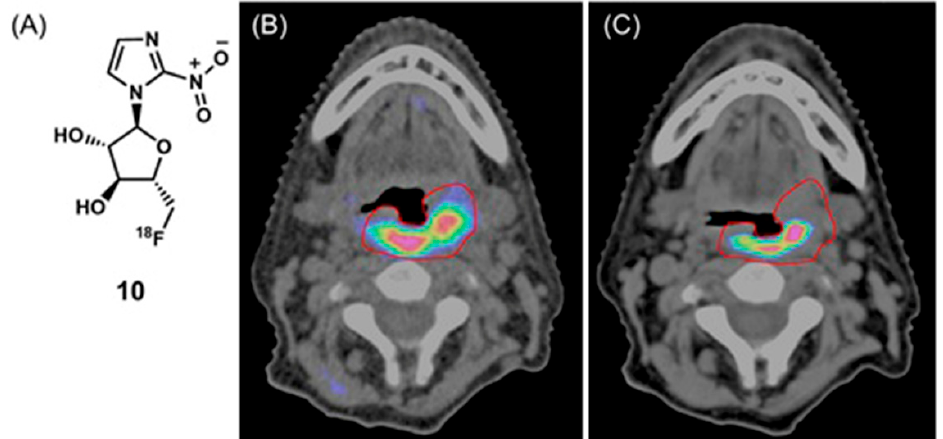
Figure 15. ( A ) Chemical structure of 10 . ( B ) PET–X-ray CT scan of a patient with oropharyngeal cancer before radiation therapy. The red solid line indicates the gross tumor volume. ( C ) Hypoxic volume after 12 Gy radiation therapy. After radiation therapy, the hypoxic volume decreased from 30.9 to 13.7 cm 3 . Adapted from Radiotherapy and Oncology , 105 , 1, Mortensen, L. S.; Johansen, J.; Kalle- hauge, J.; Primdahl, H.; Busk, M.; Lassen, P.; Alsner, J.; Sørensen, B. S.; Toustrup, K.; Jakobsen, S.; Petersen, J.; Petersen, H.; Theil, J.; Nordsmark, M.; Overgaaerd, J. FAZA PET/CT hypoxia imaging in patients with squamous cell carcinoma of the head and neck treated with radiotherapy: results from the DAHANCA 24 trial. 14–20, Copyright 2012, with permission from Elsevier [275].